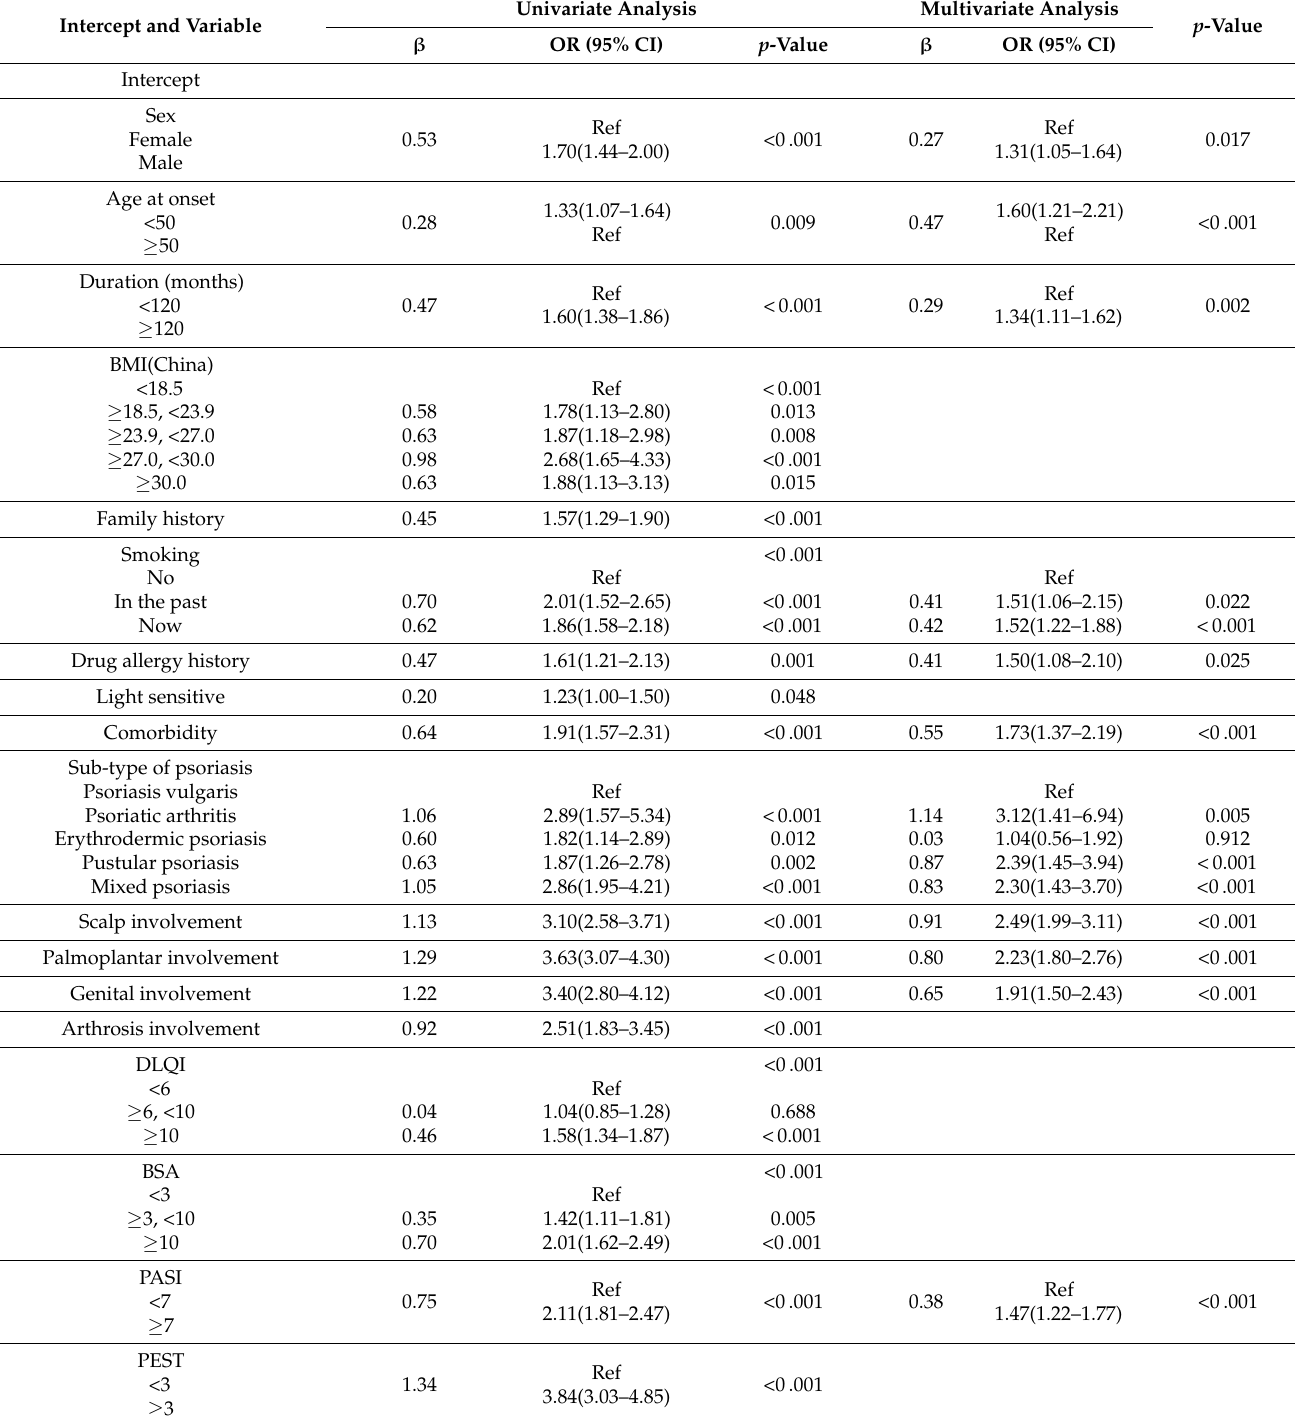
Table 3. The multivariate and univariate logistic regression analysis of nail